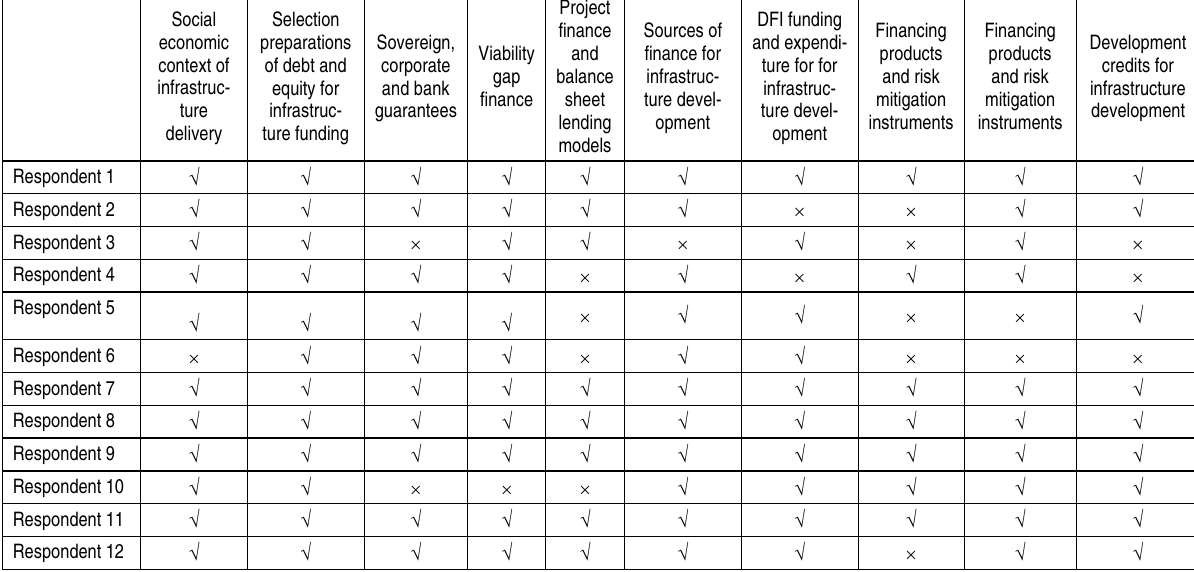
Table 3. Choice of content areas to assist respondents in the achievement of project